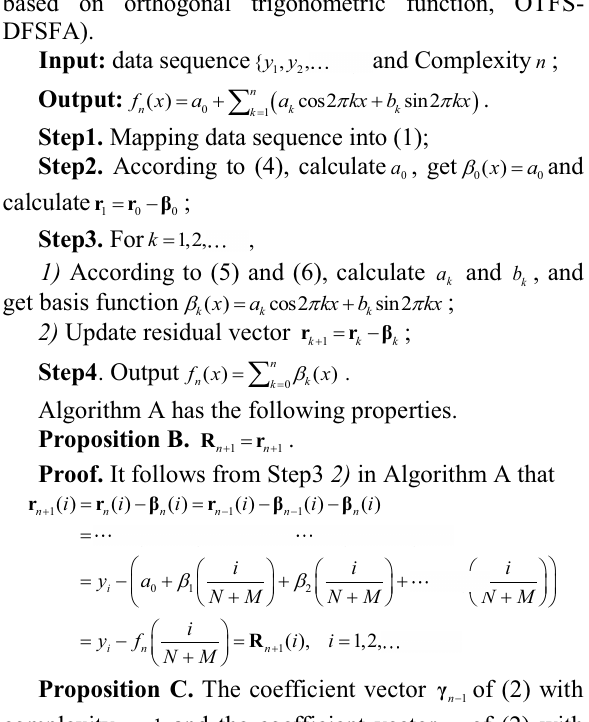
Algorithm A (Data forward stepwise fitting algorithm based on orthogonal trigonometric function, OTFS-